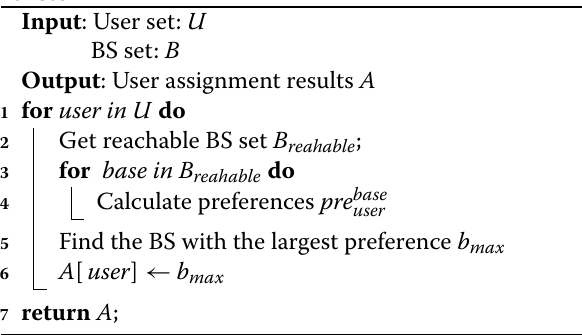
Algorithm 1 is the pseudo-code of SPF. Algorithm 1: User grouping strategy based on prefer-